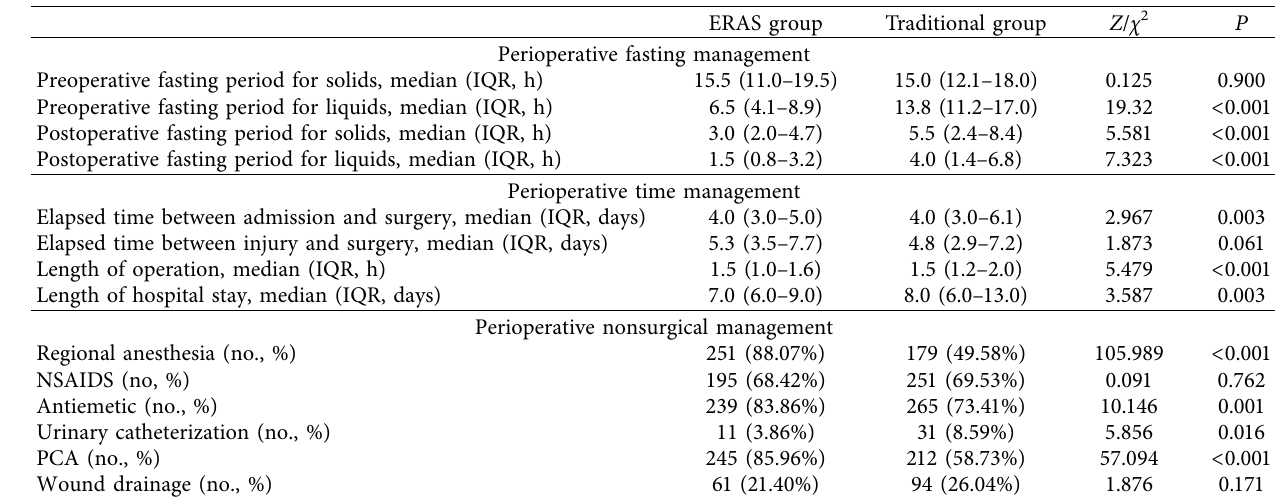
Table 3: Process of care metrics of both